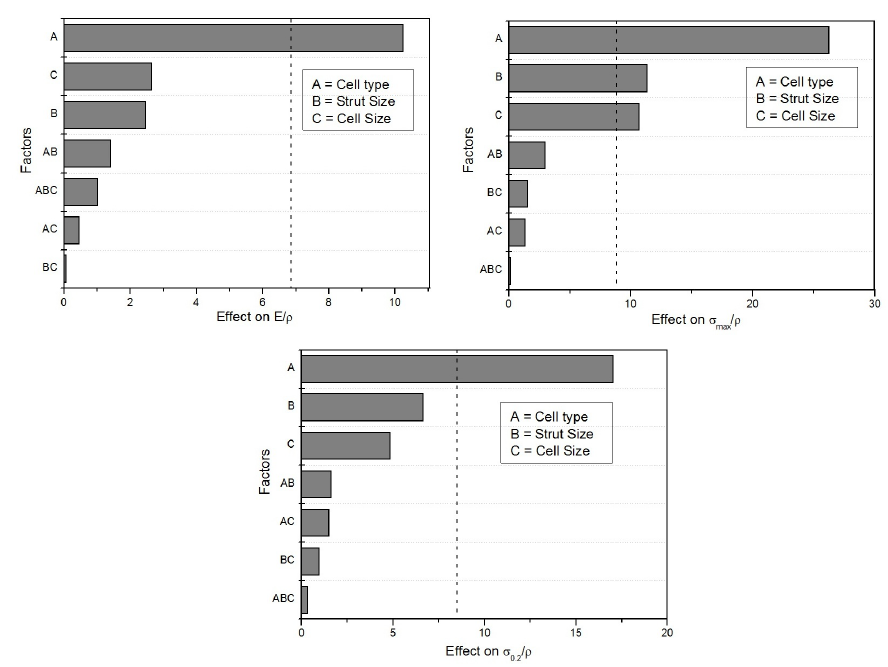
Figure 5. Pareto charts for E / ρ , σ 0.2 / ρ , and σ max / ρ